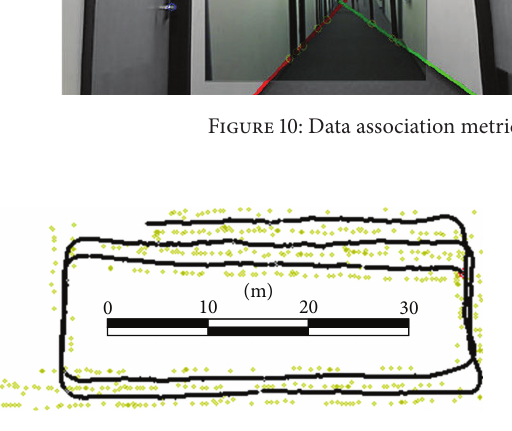
Figure 11: Map drift is one of the classic errors introduced by poor data association, or lack thereof, negatively impacting the loop- closing performance. Figure 12: Experimental results of the proposed ranging and SLAM